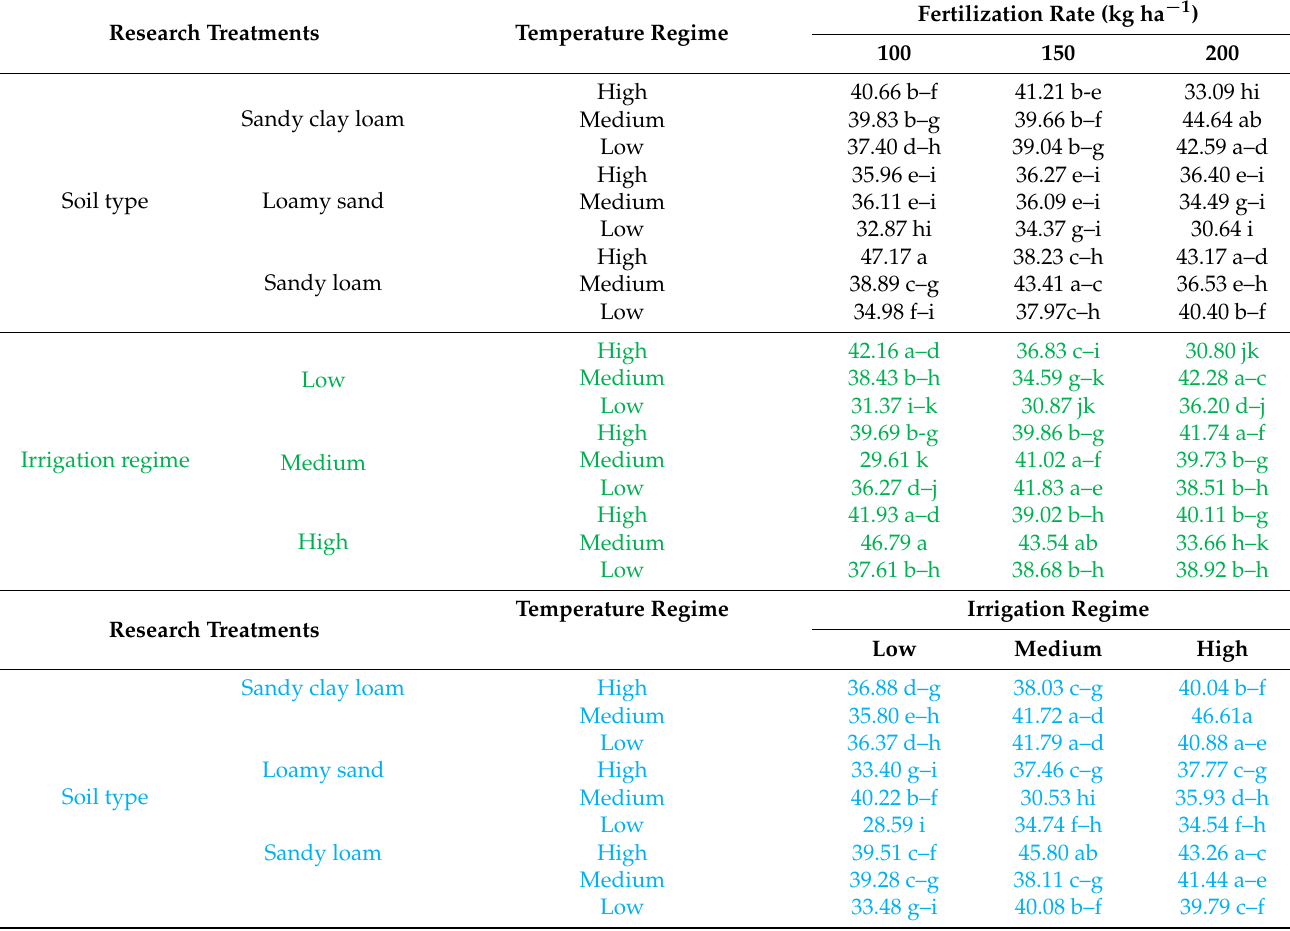
Table 2. Plant height (cm) as influenced by interaction effects of (i) nitrogen fertilizer application rate, air temperature, and soil type, (ii) nitrogen fertilizer application rate, air temperature, and irrigation regime, and (iii) irrigation regime, temperature, and soil